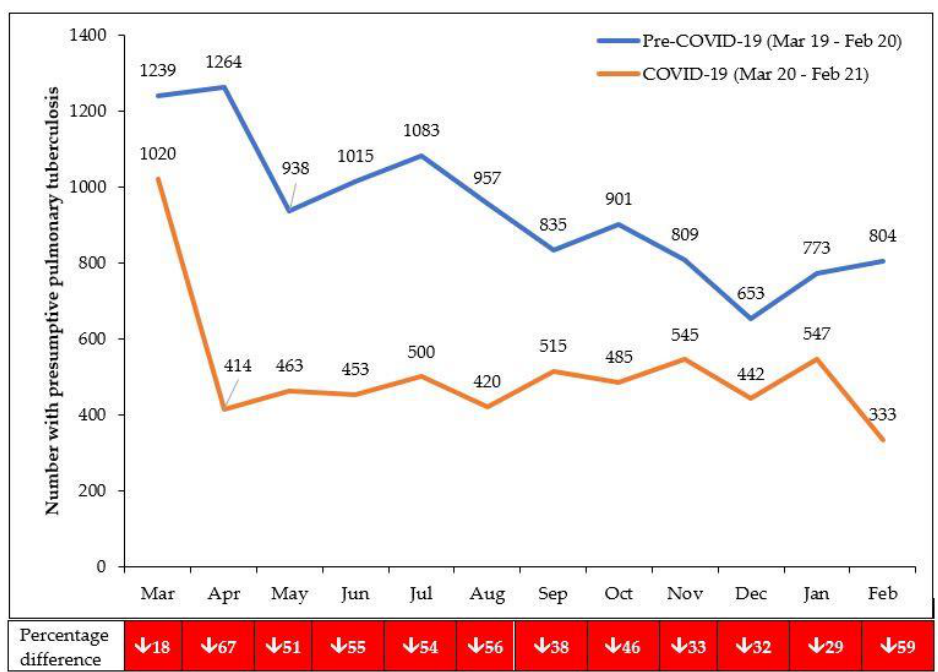
Figure 2. Numbers presenting each month with presumptive PTB in eight health facilities in Lilongwe, Malawi, during the pre-COVID-19 and COVID-19 periods. From October 2020 onwards, health workers were asked to pro-actively ask about symptoms of TB in those attending outpatient departments; there was an active tracing of patients needing to be registered.